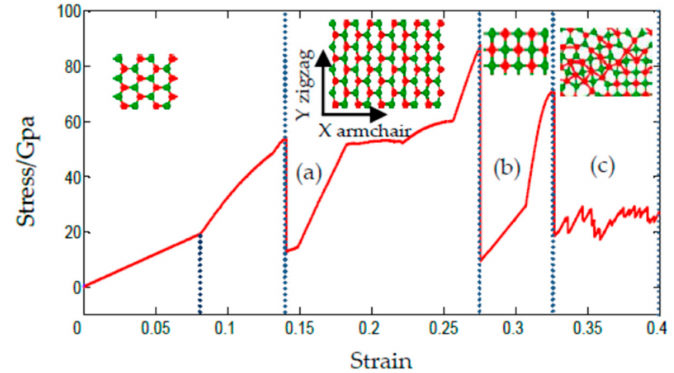
Figure 7. The stress–strain curves of the SLMoS2 nanosheets under uniaxial compression along the armchair direction. The insets show ( a ) The distorted hexagonal lattice; ( b ) the quadrilateral lattice; ( c ) the buckling.